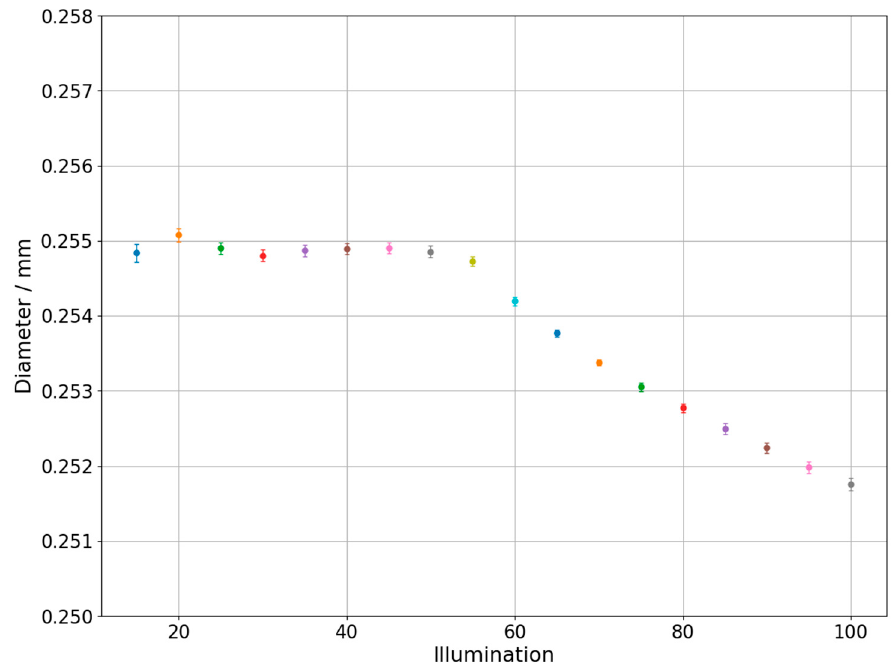
Figure 5. Diameter changes depending on the applied backlight. Glass plate standard measurement.